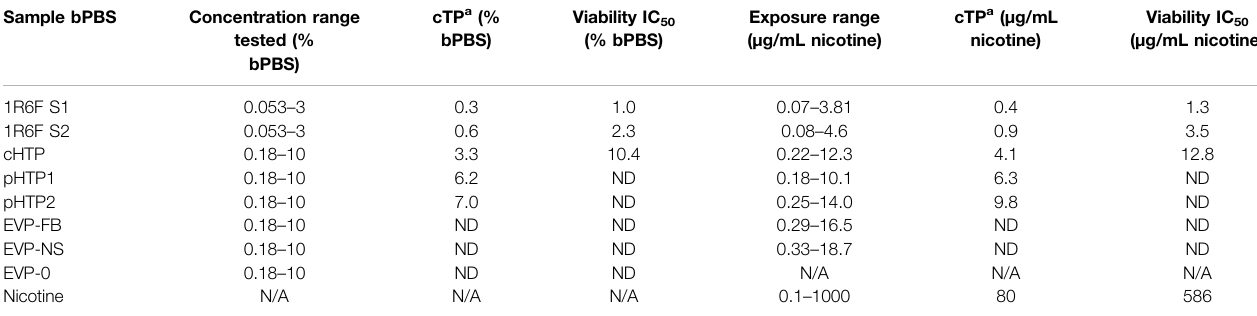
TABLE 5 | Cardiotoxicity potential summary for smoke or aerosol trapped bPBS from reference cigarettes and NGPs. Sample bPBS